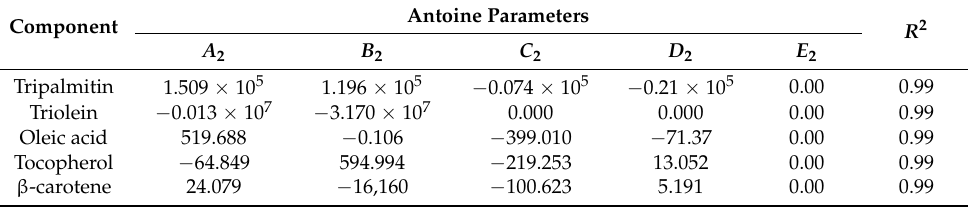
Table 4. Estimated pure component parameters for modified Antoine equation (Equation (3)).